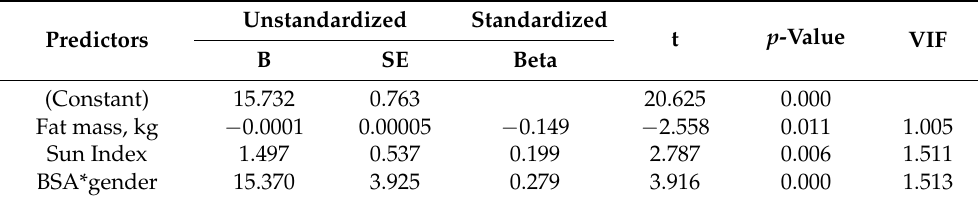
Table 4. Stepwise regression for predictors of serum 25(OH)D ( N = 243). Unstandardized Predictors